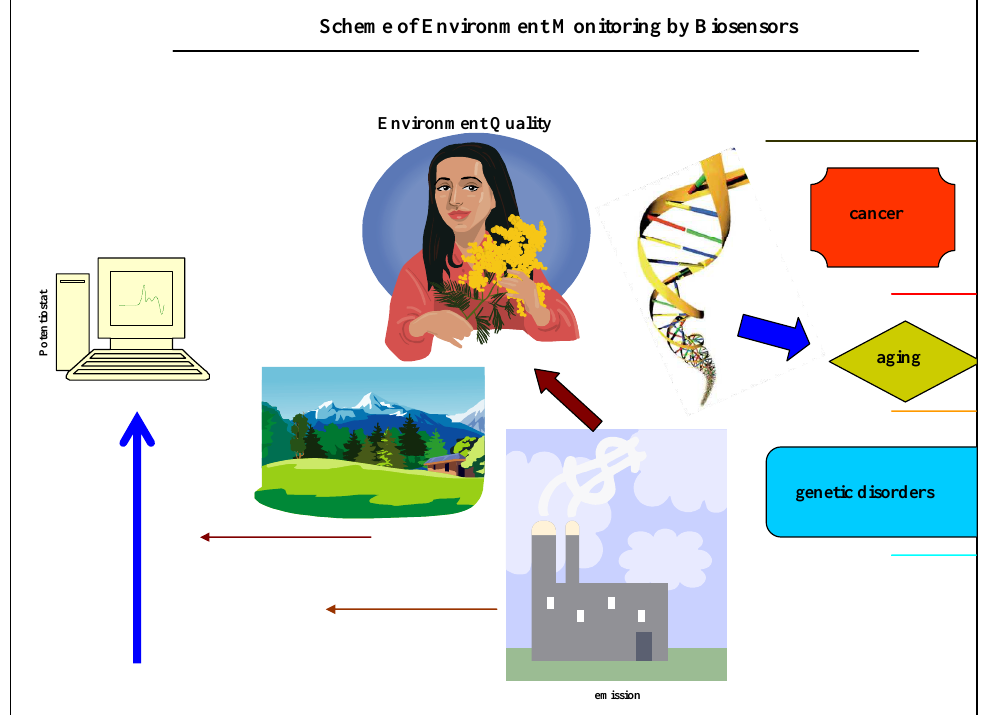
Figure 2. Schematic of environmental monitoring using